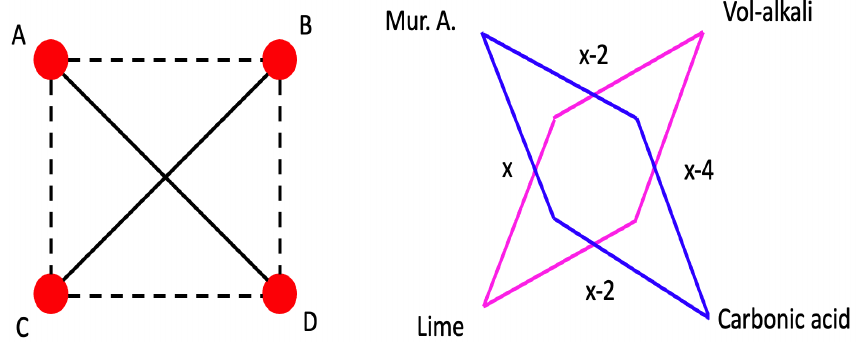
Figure 1. Examples of the earliest chemical graphs Cullen and Black developed to depict chemical interactions in